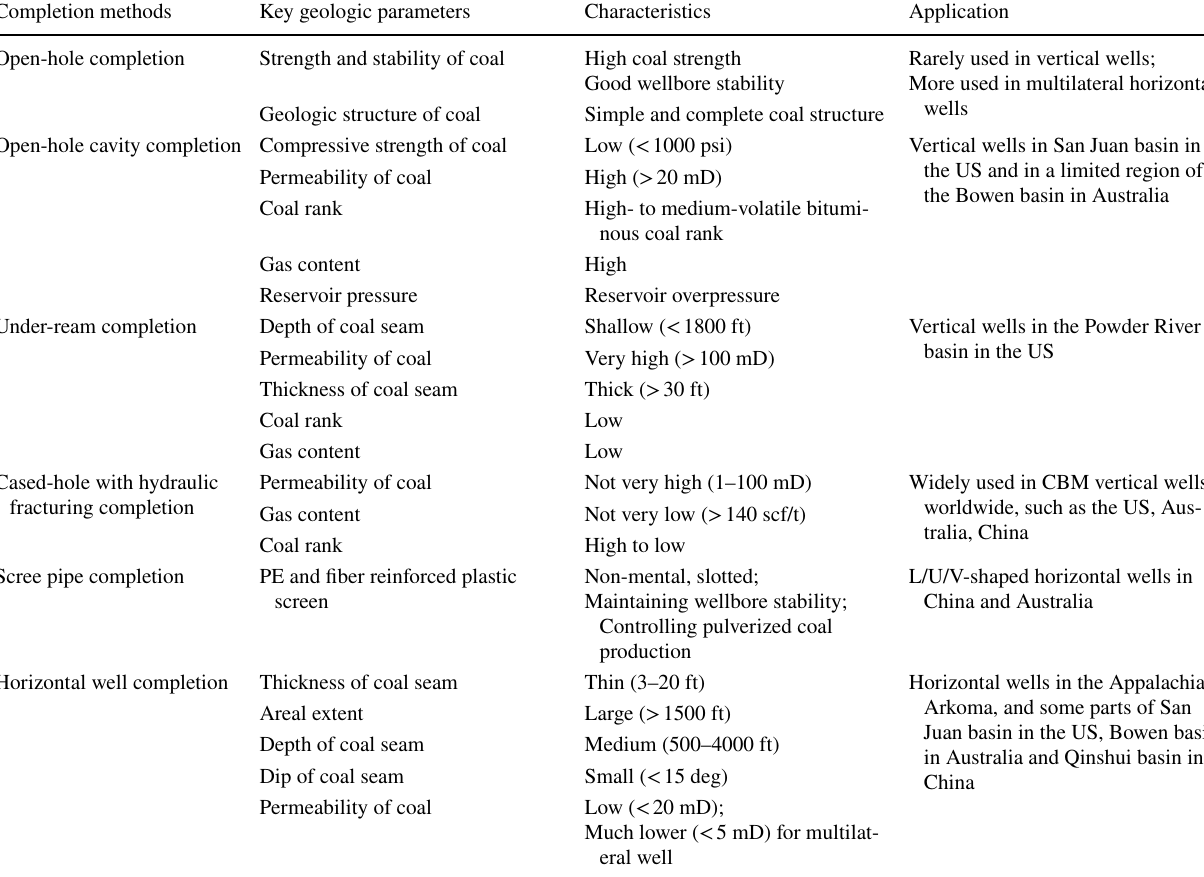
Table 9 The selection method of completion technologies for CBM well, after Ramaswamy (2008), Palmer (2010), Shen et al. (2017), Gao et al.